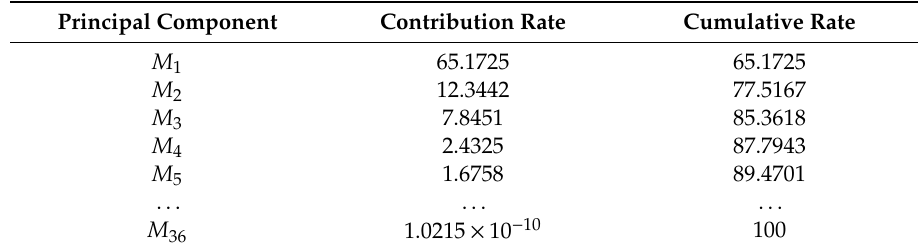
Table 3. PCA algorithm parameter